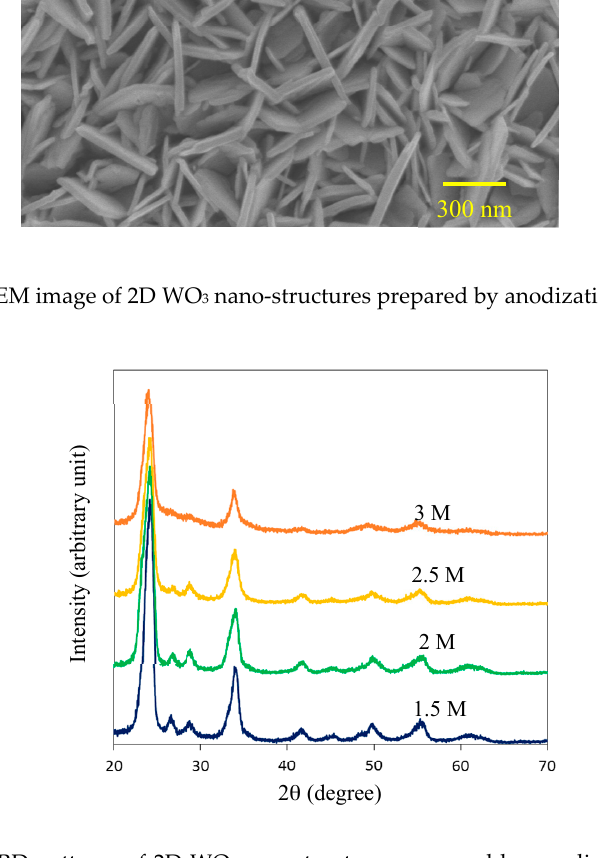
Figure 2. Typical XRD patterns of 2D WO 3 nanostructures prepared by anodization with different HNO 3